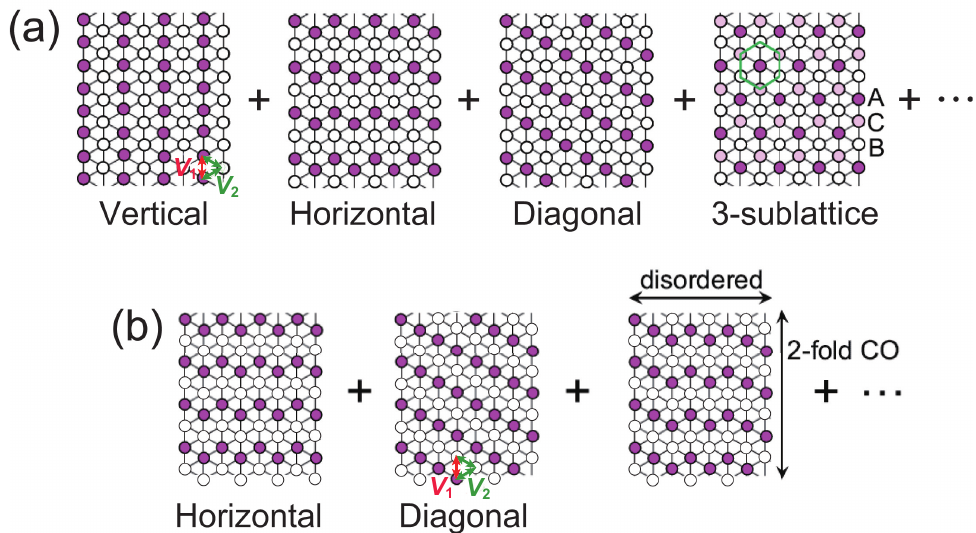
Figure 6. Schematic charge configurations on triangular lattices. ( a ) Charge configurations on the isosceles triangular lattice. Vertical, horizontal, diagonal, and three-sublattice COs are described. In the three-sublattice structure, the sublattice A is filled by one hole (pin), the sublattice B is empty, and the sublattice C is randomly occupied by the remaining holes (ball). The green hexagon stands for the unit cell. ( b ) Chain striped CO patterns on the isosceles triangular lattice, such as horizontal and diagonal COs. V 1 and V 2 ( V 1 > V 2 ) are the nearest-neighbor Coulomb interactions. Since all these states are degenerate in the classical limit of the t - V model, the classical ground state can be described by the superposition of these states. The magenta and white circles represent the charge-rich and charge-poor sites,